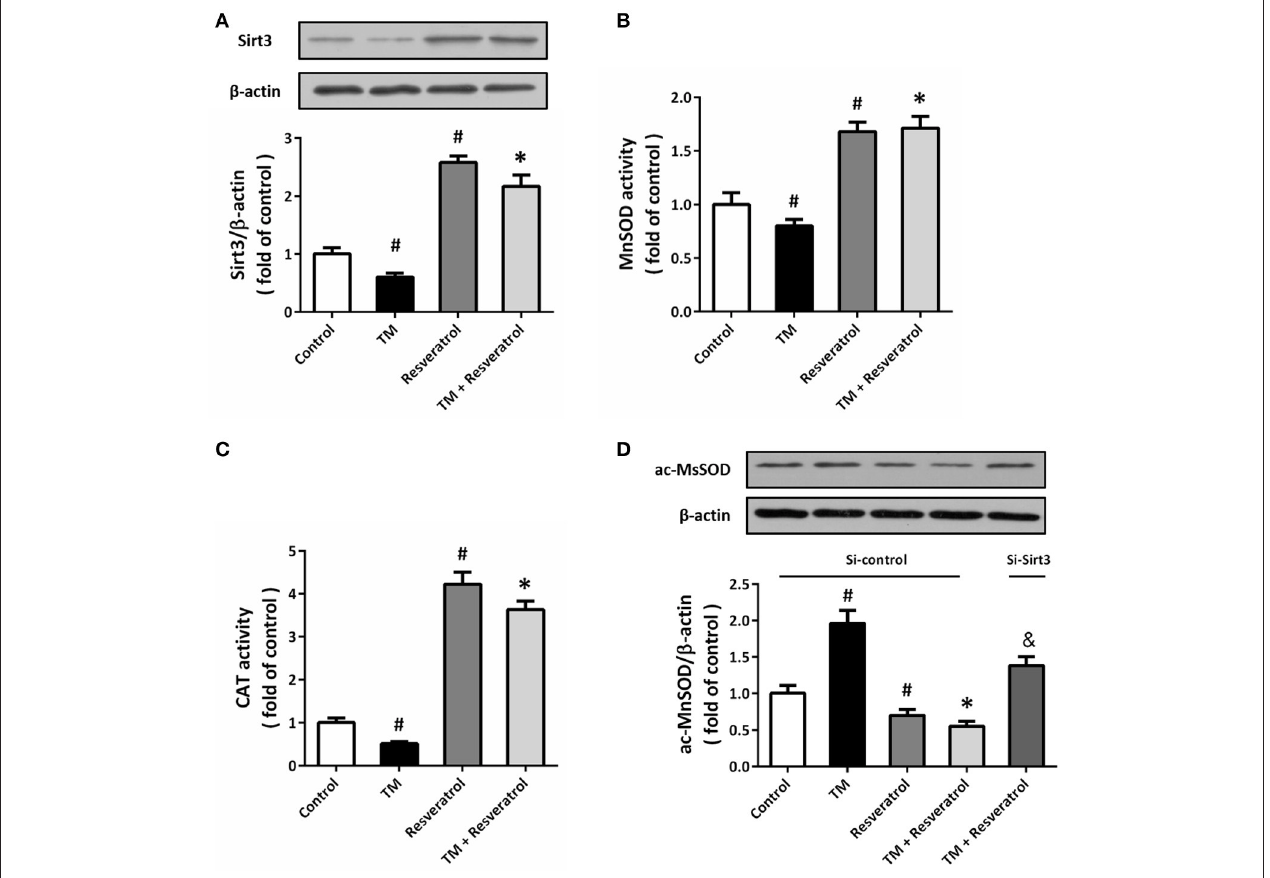
FIGURE 5 | Resveratrol activates Sirt3 in TM-treated HT22 cells. HT22 cells were treated with 100ng/ml TM with or without 50 µ M resveratrol for 24h. The expression of Sirt3 protein was detected by western blot (A) , and the enzymatic activities of MnSOD (B) , and CAT (C) were determined. HT22 cells were transfected with Si-control or Si-Sirt3 for 48h, and treated with 100ng/ml TM with or without 50 µ M resveratrol for 24h. The expression of ac-MnSOD was detected by western blot (D) . Data are shown as mean ± SEM. # p < 0.05 vs. Control. * p < 0.05 vs. TM. & p < 0.05 vs.